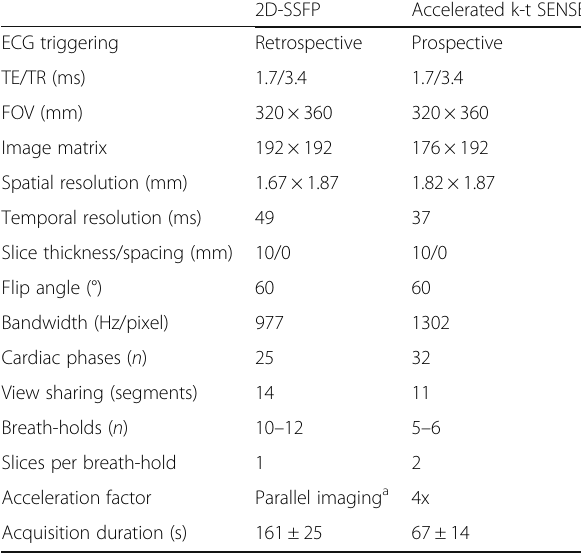
Table 1 Imaging